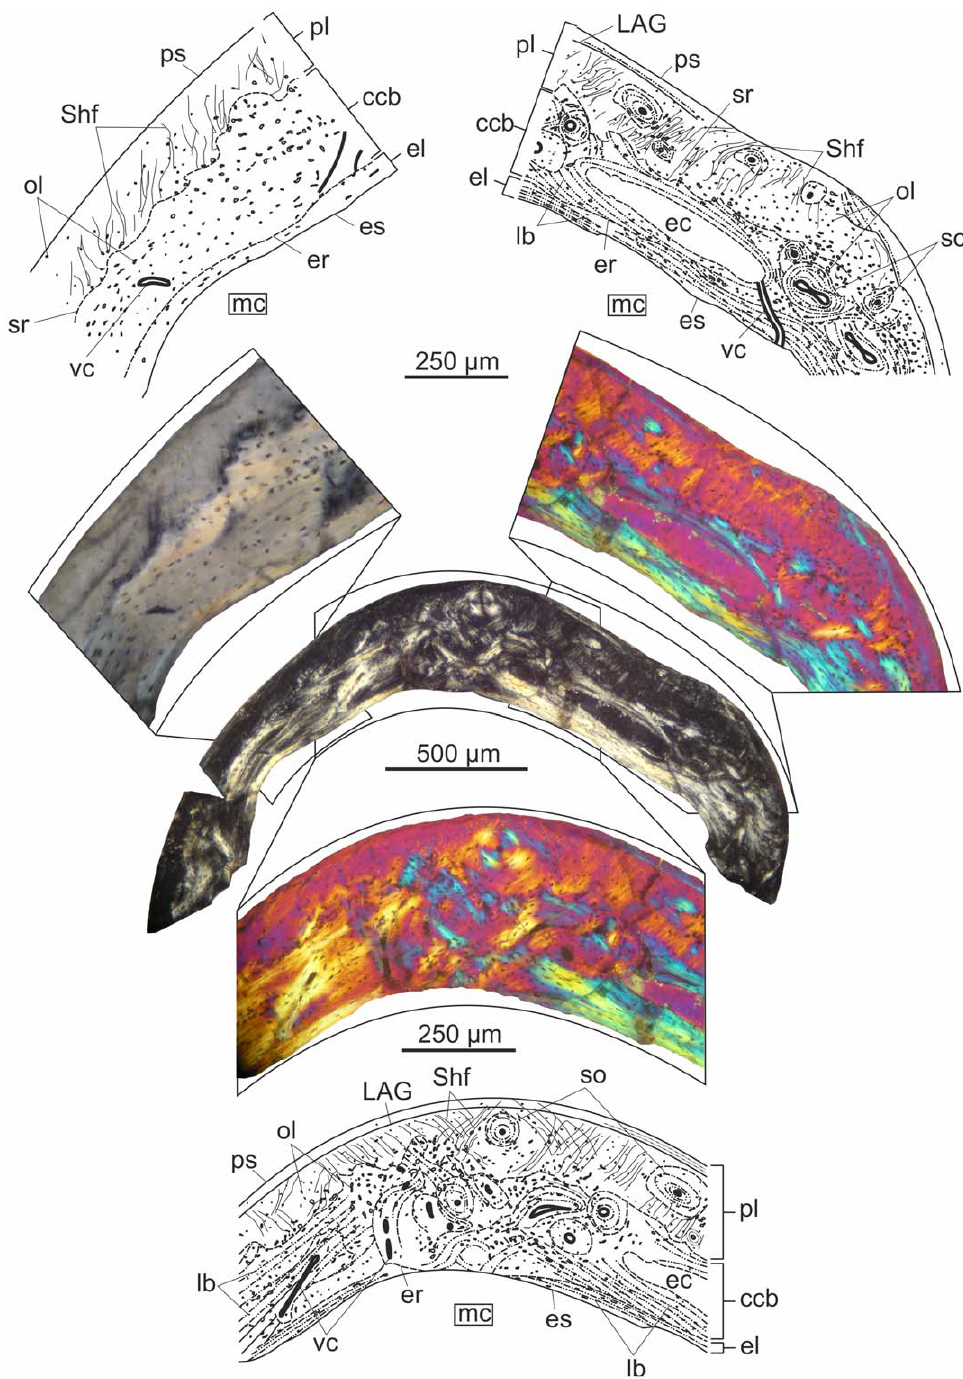
Figure 5. Femoral histology of MTM 2008.33.1. under normal polarized light and crossed nicols. Thick endosteal layer merges into compacted coarse cancellous bone which forms the majority of the cortex. The periosteal outer layer is parallel-fibred, almost avascular with a few scattered secondary osteons and dense network of Sharpey’s fibres.